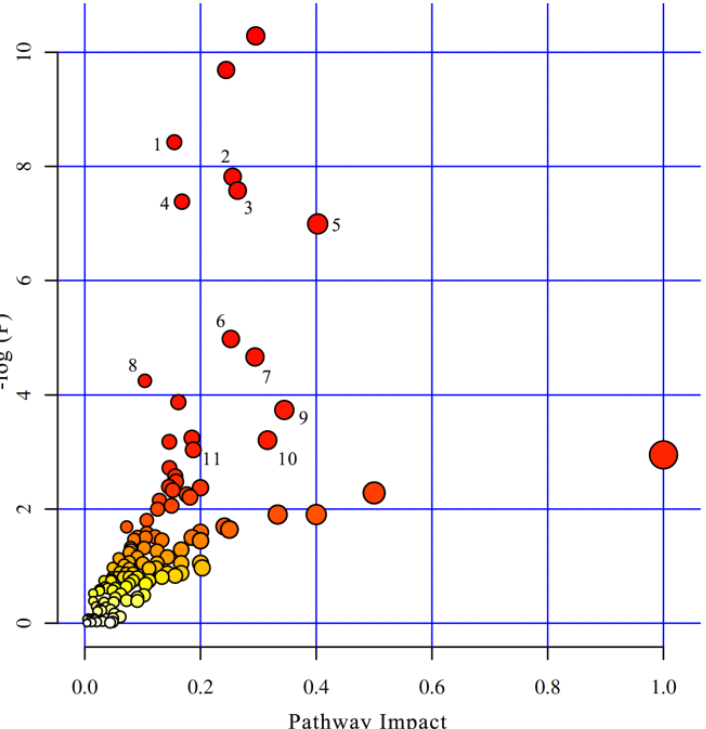
Figure 4. The metabolome-view map of significant metabolic pathways. 1. Phenylalanine metabo- lism; 2. TCA cycle; 3. Tyrosine metabolism; 4. Arginine biosynthesis; 5. Arginine and proline me- tabolism; 6. GABAergic synapse; 7. Lysine degradation; 8. Beta-Alanine metabolism; 9. cAMP sig- naling pathway; 10. HIF-1 signaling pathway; 11. Vascular smooth muscle contraction.